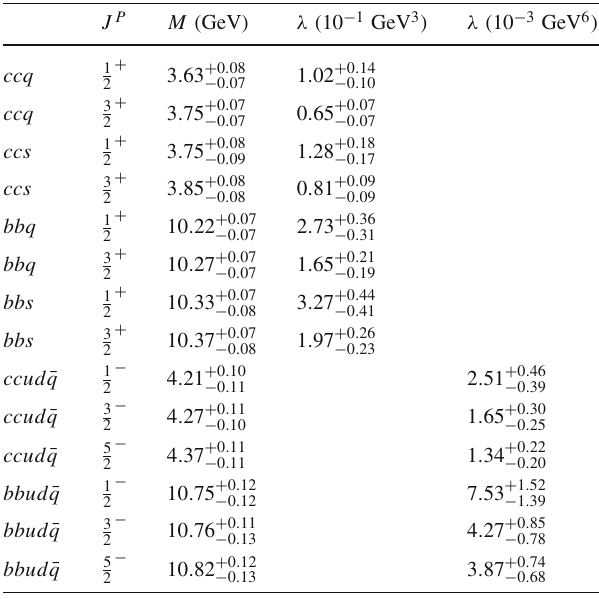
Table 3 The masses and pole residues of the doubly heavy baryon states and pentaquark